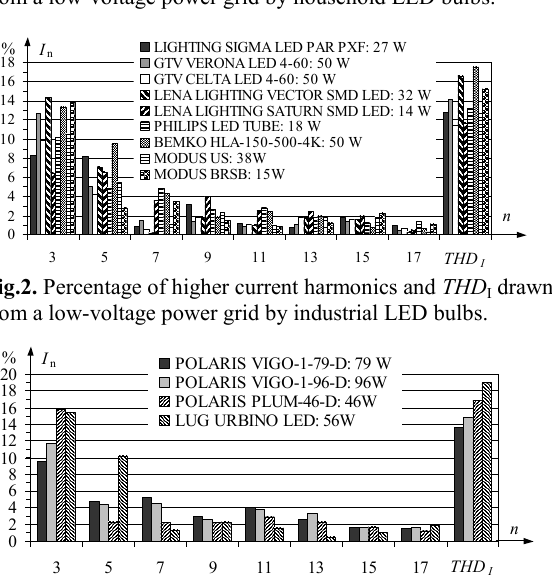
Fig.1. Percentage of higher current harmonics and THD I drawn from a low-voltage power grid by household LED bulbs.